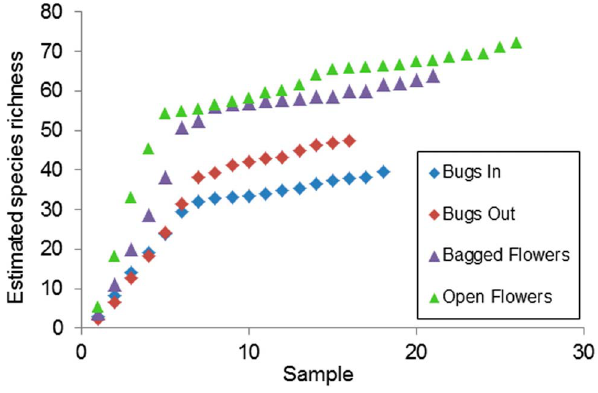
Figure 3. Estimated species richness (calculated as average of Chao2, Jackknife1 and ICE) in floral nectar of Asphodelus aestivus (open and bagged flowers) and in and out the mirid bug Capsodesinfuscatus . The curves of the expected species richness approximately reach an asymptote, demonstrating that only a few more species would have been collected had the sampling effort been further increased.